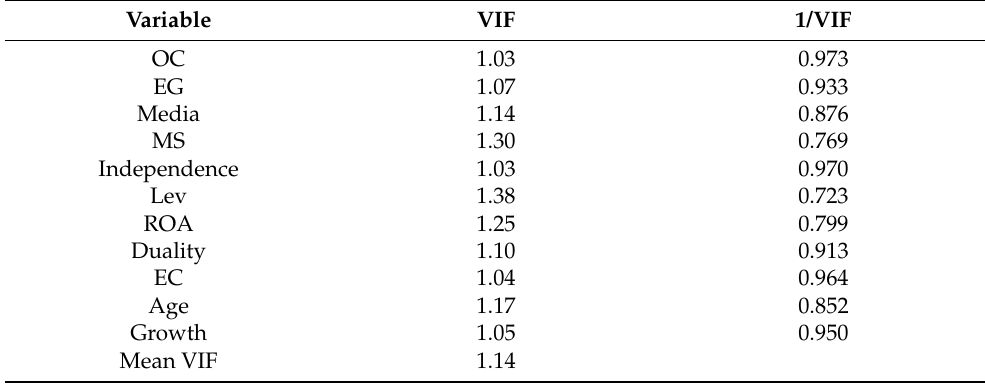
Table 4. The variance inflation factor (VIF) of